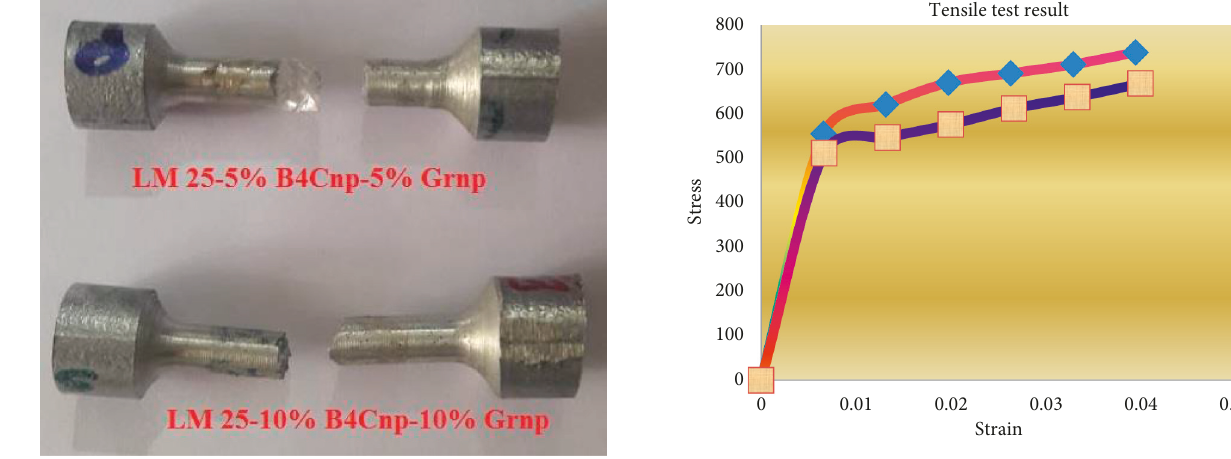
Figure 7: Microtensile test specimen.